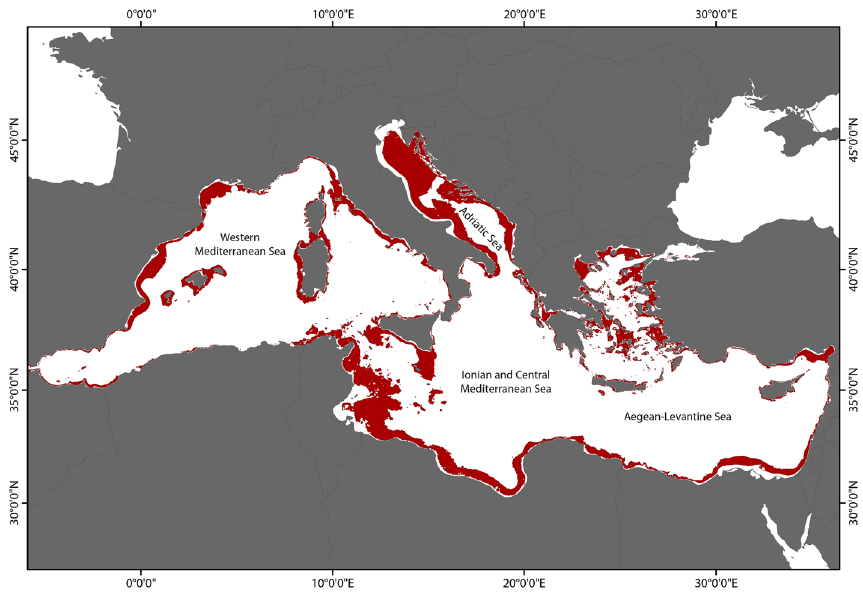
Figure 2. Estimated spatial extent of the mesophotic zone in the Mediterranean Sea. Portions of seabed characterized by mesophotic conditions (red shaded area). The upper and lower limits were set at 30 m depth and at 0.0001 mol photons m −2 day −1 of irradiance, respectively. Map generated using ArcMap 10.5 software (© ESRI, https:// deskt op. arcgis.